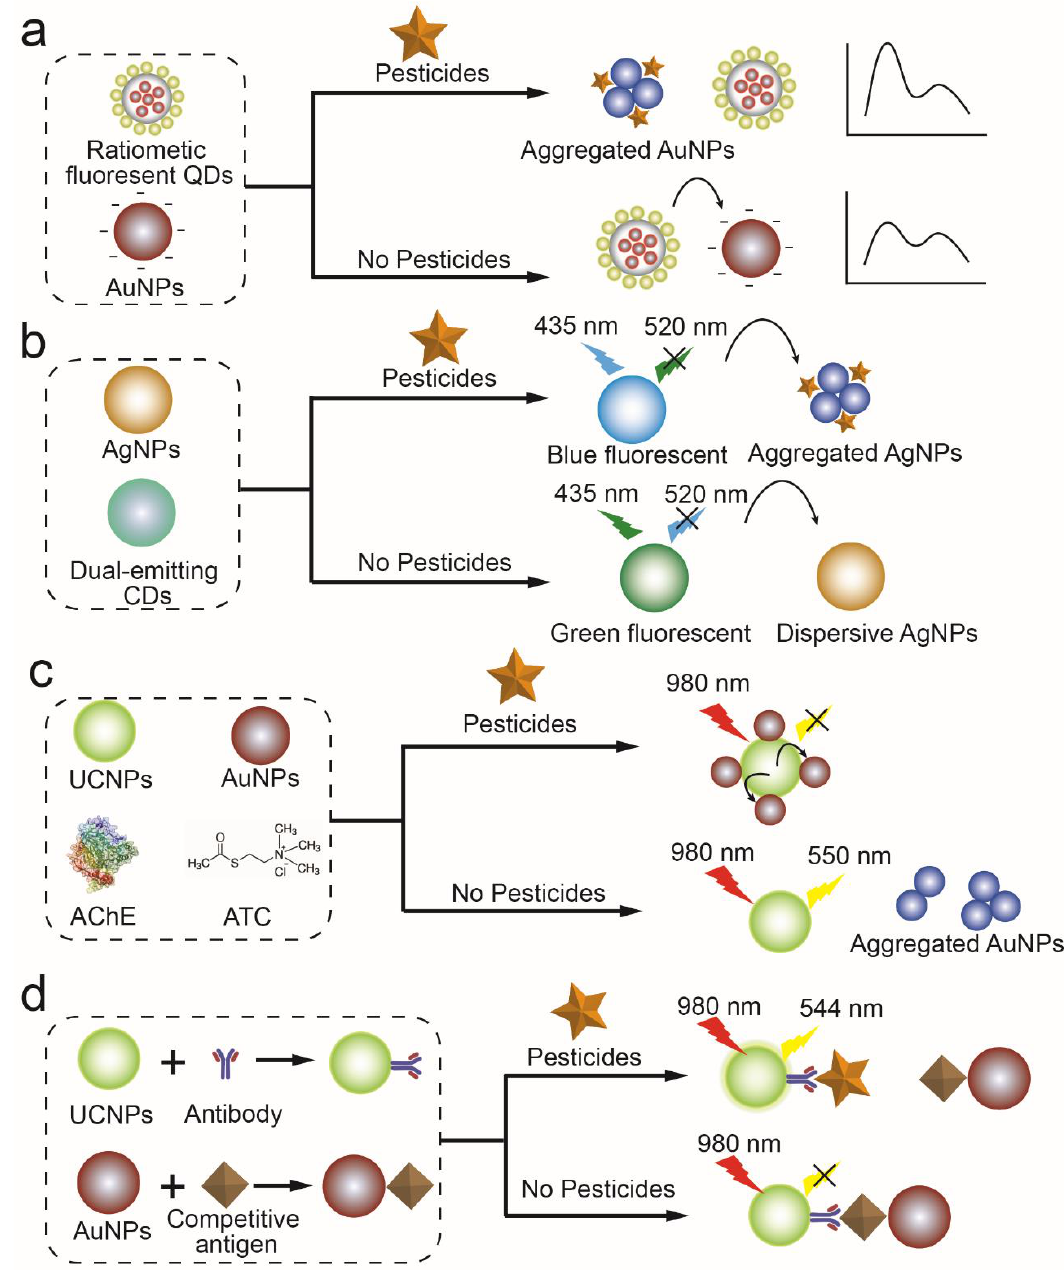
Figure 4. Detection of pesticides based on the fluorescence enhancement or quenching of nanopar- ticles ( a ) IFE indicated an acetamiprid sensor based on AuNPs on QDs [37]. ( b ) fluorometric dual- channel ratiometric determination of the fungicide cymoxanil based on an analyte-induced aggre- gation of AgNPs and dual-emitting CDs [38]. ( c ) UCNPs-AuNPs-based FRET assay for the detection of organophosphorus pesticides [36]. ( d ) immunoassay of acetamiprid by using IFE of AuNPs on UCNPs [41].